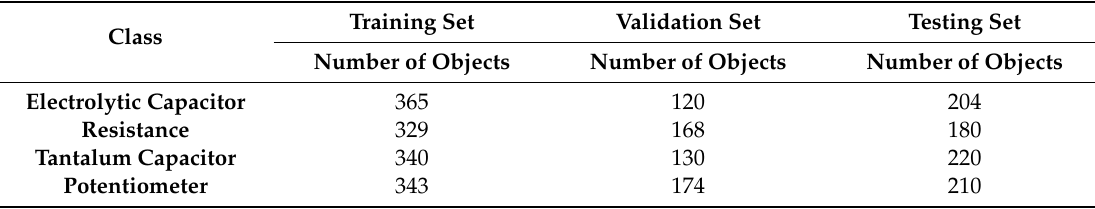
Table 1. The composition of training, validation, and testing sets.